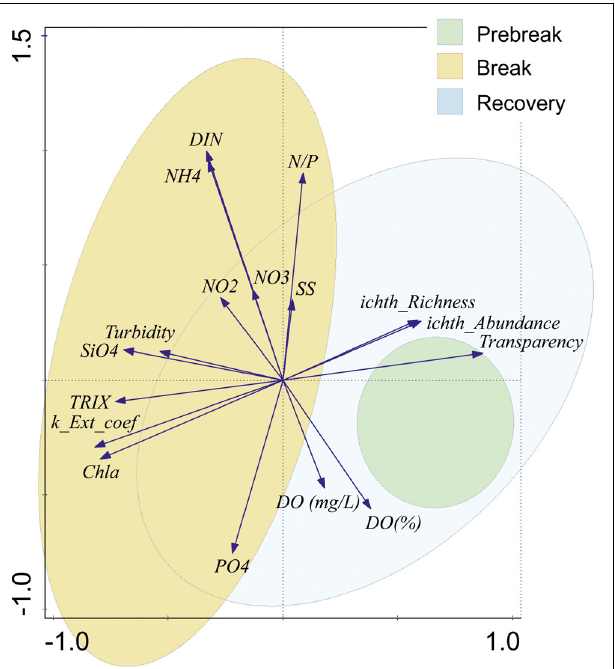
FIGURE 7 | Biplot representations of the first two axes of the PCA performed on the campaigns’ matrix of trophic variables (averaged for the lagoon) sampled from 1997 to 2018 in the Mar Menor lagoon identifying the trophic status phase to which they correspond. Ellipses represent 95% confidence level for samples